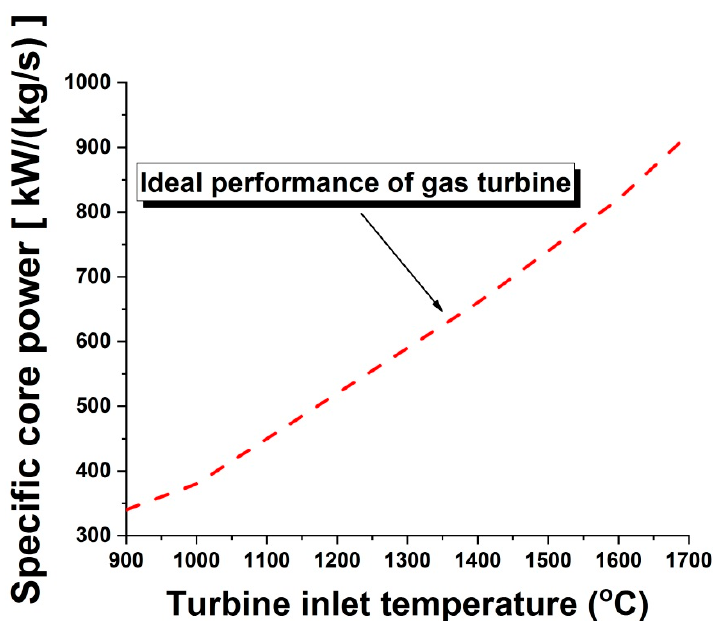
Figure 2. Specific core power versus turbine inlet temperature—adapted from [18].